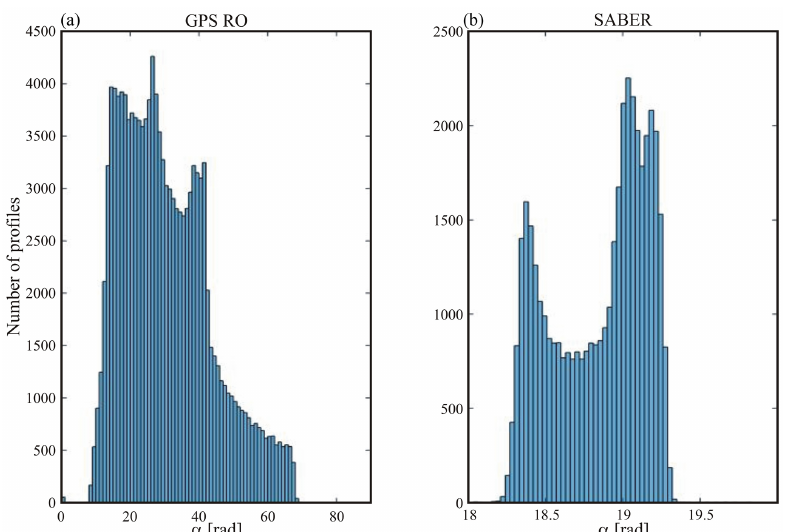
Figure 5. Distribution of available profiles with elevation angle between the sounding path direction and the horizontal plane, globally retrieved, during the period January–February 2009 from (a) GPS-LEO RO and (b) TIMED/SABER measurements (see text). The total number of profiles are 127617 and 83712 respectively.